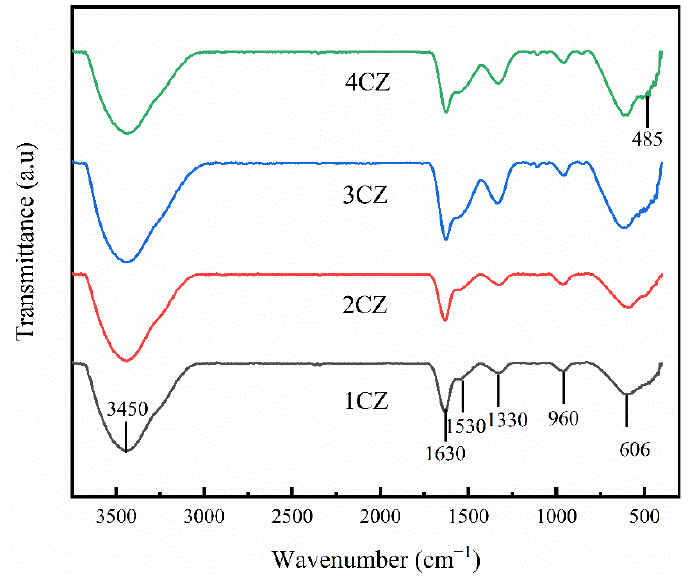
Figure 4. FTIR spectra for the CZ